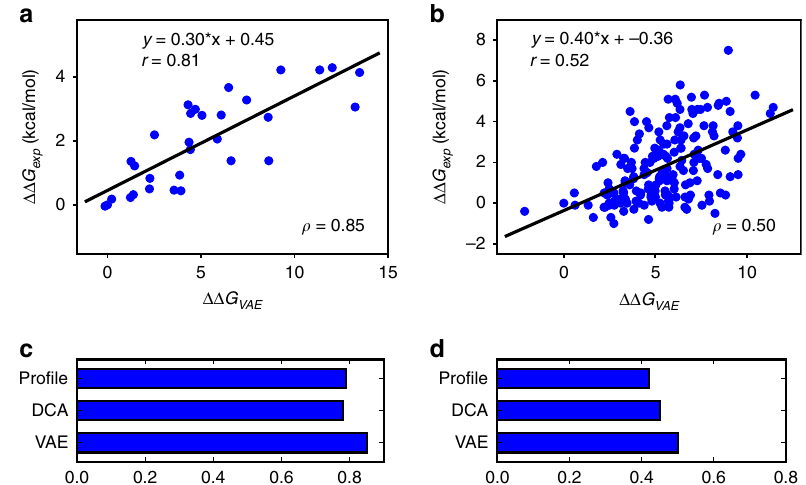
Fig. 5 Predicting protein stability change upon mutations. a , b Correlation between experimental stability change and VAE free energy change upon single-site mutations for fi bronectin type III domain ( a ) and staphylococcal nuclease ( b ). ΔΔ G is experimental protein folding free energy change upon exp single-site mutations compared with the wild type protein. ΔΔ G is VAE free energy change upon single-site mutations. ΔΔ G is calculated as the VAE VAE change of negative log-likelihood of sequences when single-site mutations are introduced. Therefore, ΔΔ G is an unitless quantity. Each point VAE corresponds to a mutant sequence with one mutation compared with the wild-type sequence. r and ρ are Pearson ’ s correlation coef fi cients and Spearman ’ s rank correlation coef fi cients, respectively. c , d In addition to latent models trained with VAEs, similar analysis is conducted using sequence pro fi le and DCA methods. Spearman ’ s rank correlation coef fi cients between experimental protein folding free energy change upon single-site mutations and free energy change calculated using the three methods are compared for the same two protein families: fi bronectin type III domain ( c ) and staphylococcal nuclease ( d